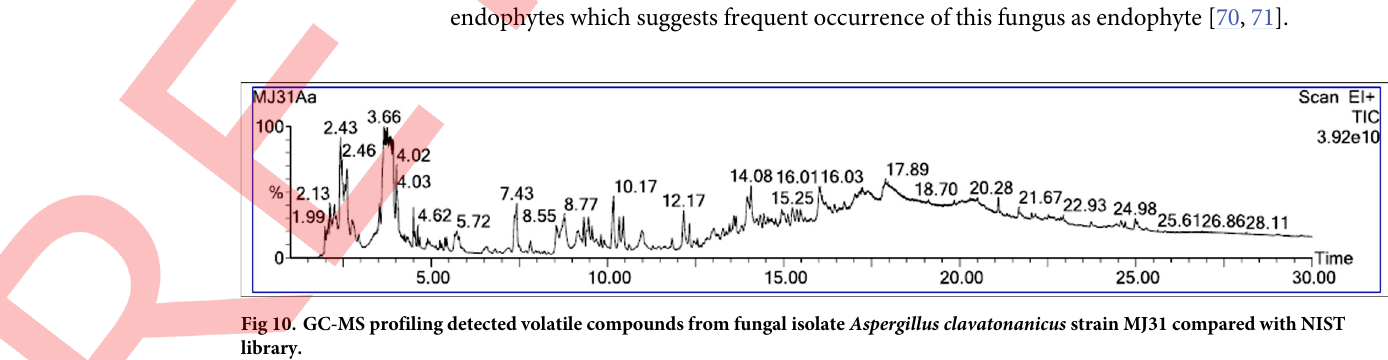
Fig 10. GC-MS profiling detected volatile compounds from fungal isolate Aspergillus clavatonanicus strain MJ31 compared with NIST library.